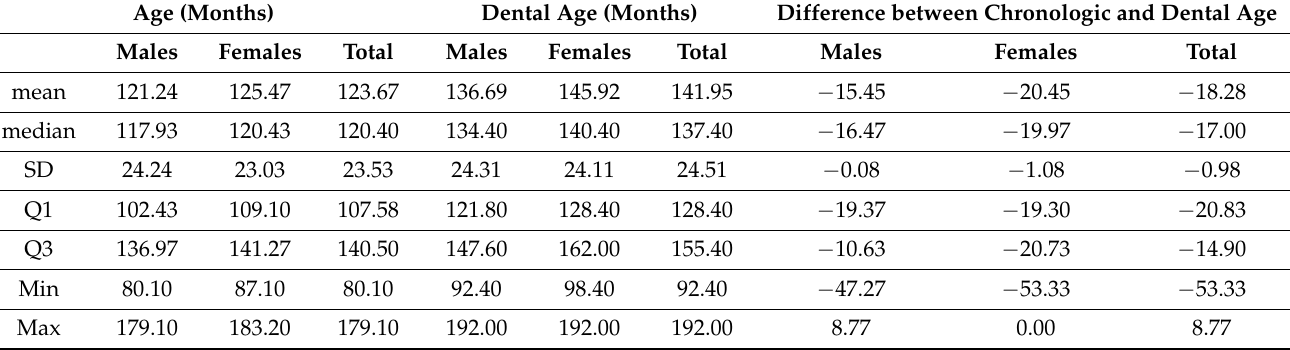
Table 1. Distribution of the study group according to chronologic and dental